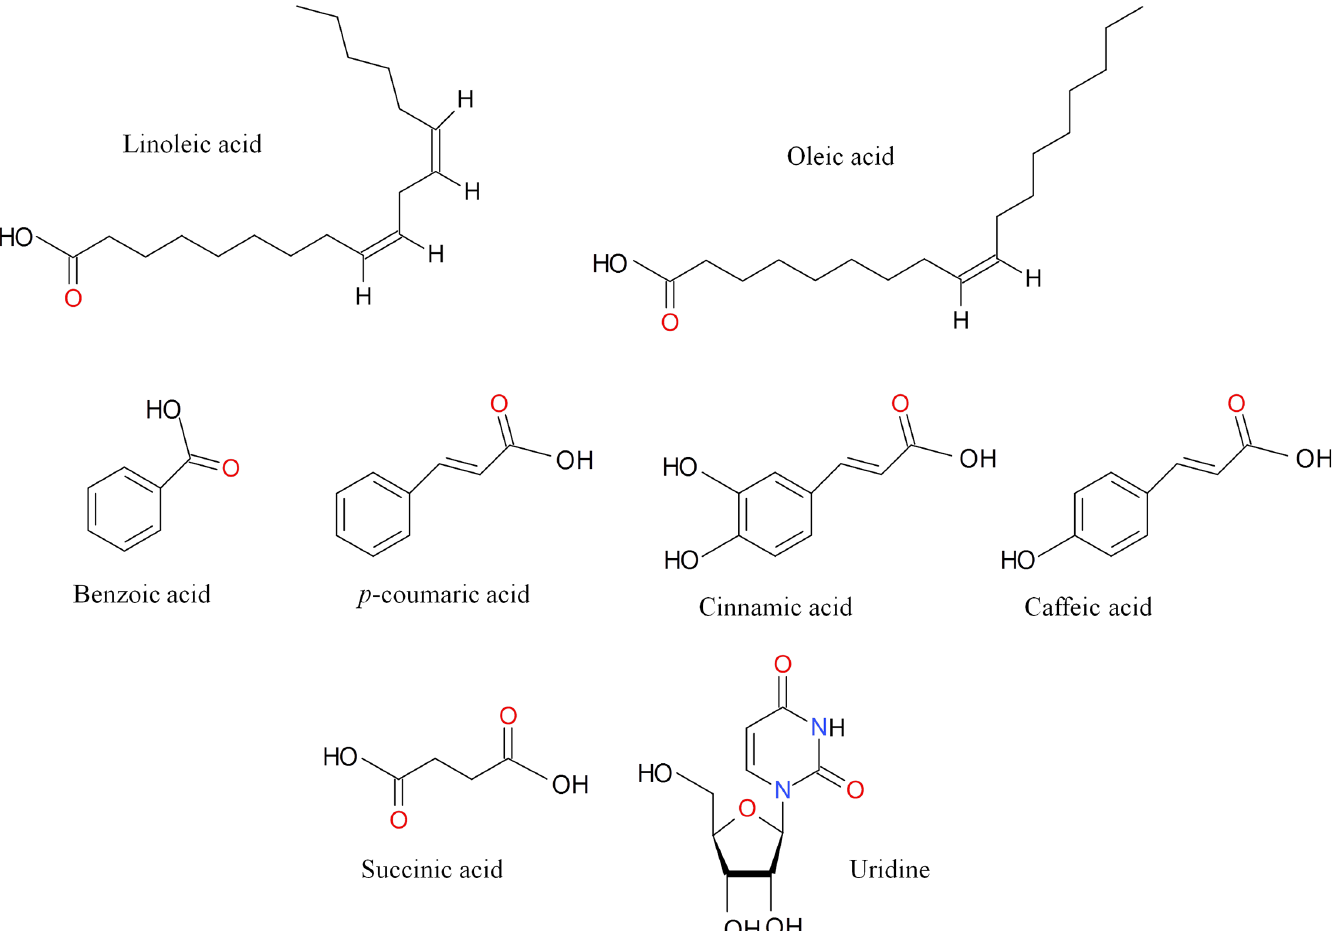
Fig 1. Compounds detected in the basidiocarps of P . giganteus